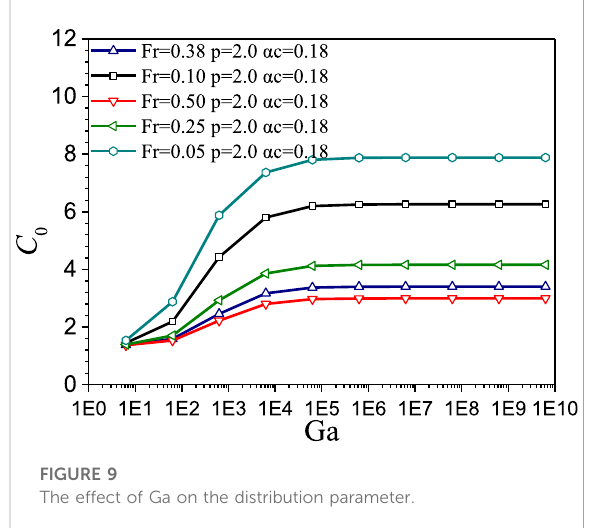
FIGURE 9 The effect of Ga on the distribution parameter.